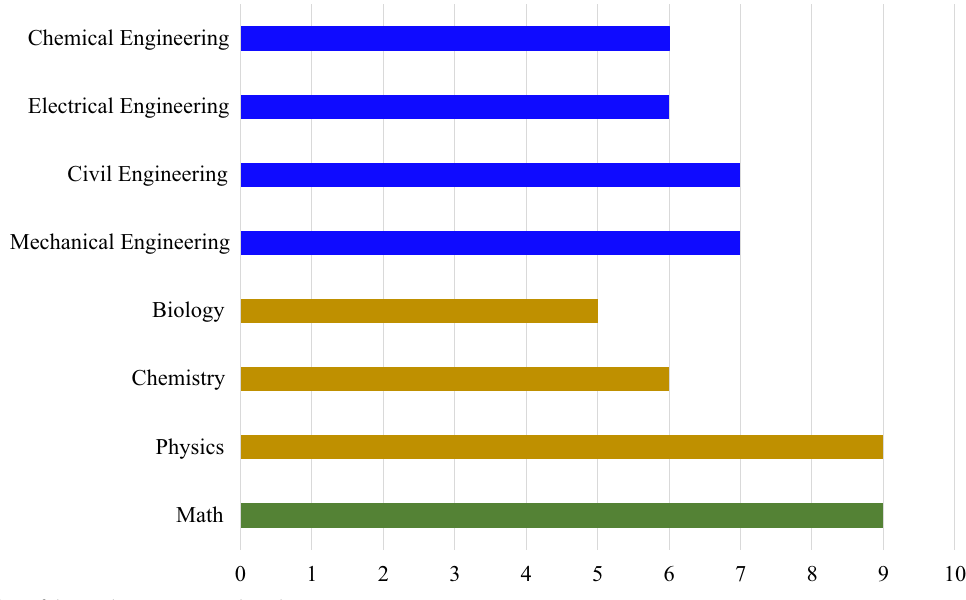
Fig. 2 Number of doctoral programs per